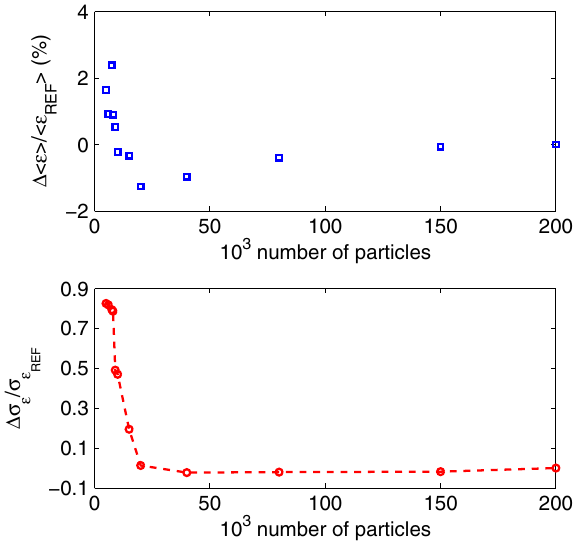
FIG. 3. Mean (top plot) and standard deviation (bottom plot) of the emittance of the slices along the central 3 = 4 of the total bunch length versus the number of particles used in the simulation with respect to the case using 200 thousand